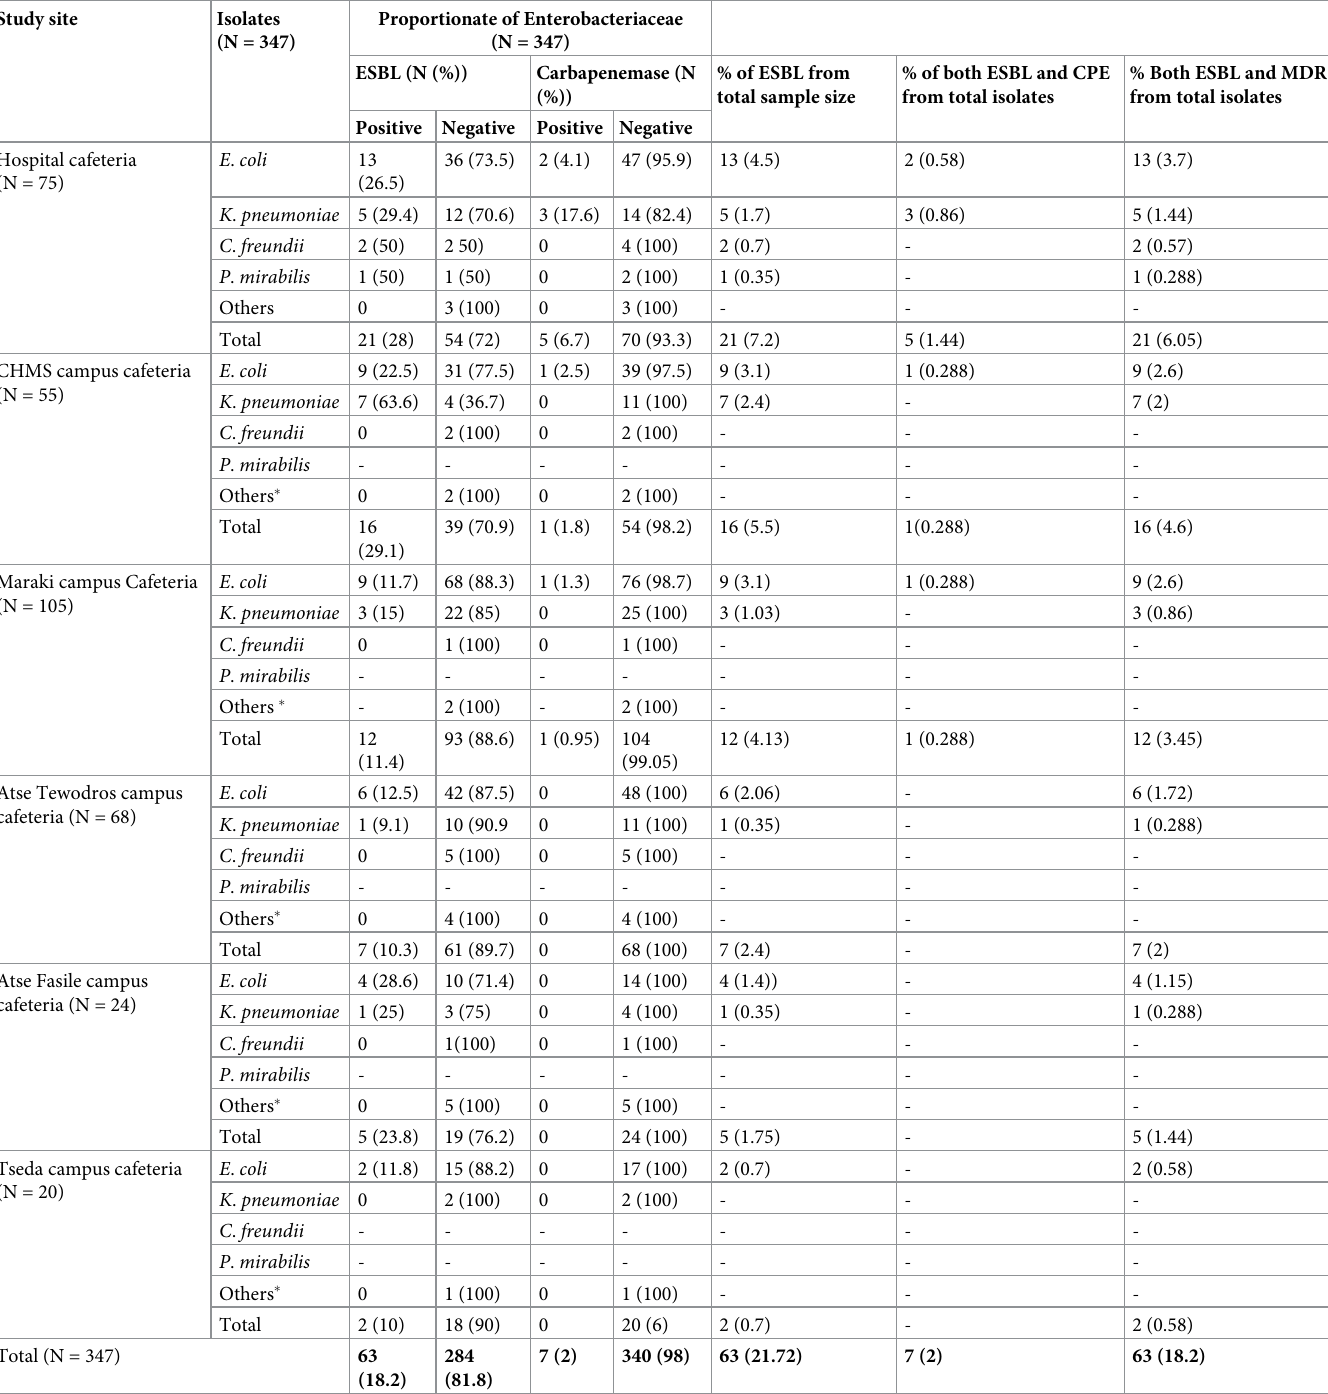
Table 5. Distribution of ESBL-PE, Carbapenemase-producing Enterobacteriaceae, and MDR isolate among food handlers at the University of Gondar Comprehen- sive Specialized Hospital and Students’ Cafeterias, Northwest Ethiopia, February to June 2021. Study